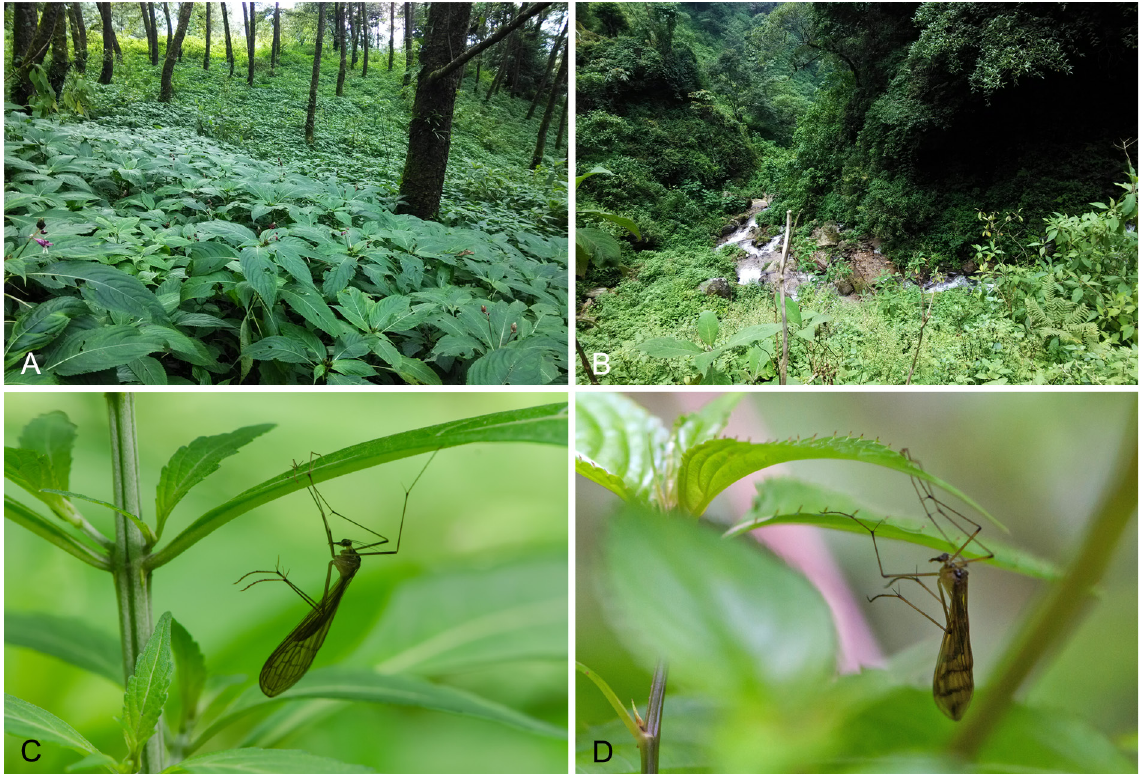
Fig. 9. Habitats of Terrobittacus spp. A–B . Habitats. C . Female specimen of T. rostratus sp. nov. in repose. D . Female specimen of T. angustus sp. nov. in repose. (photos by